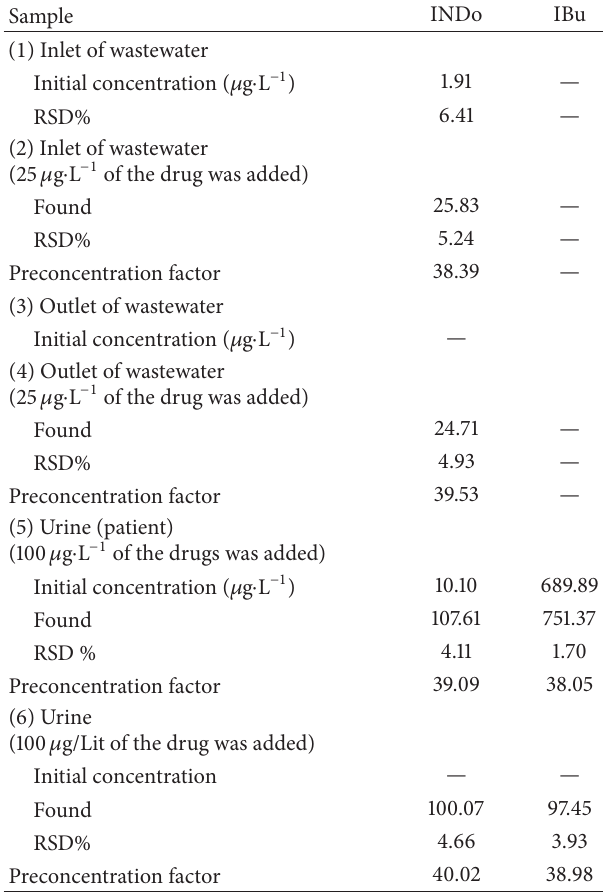
Table 3: Determination of the INDO in wastewater and INDO, IBU in urine